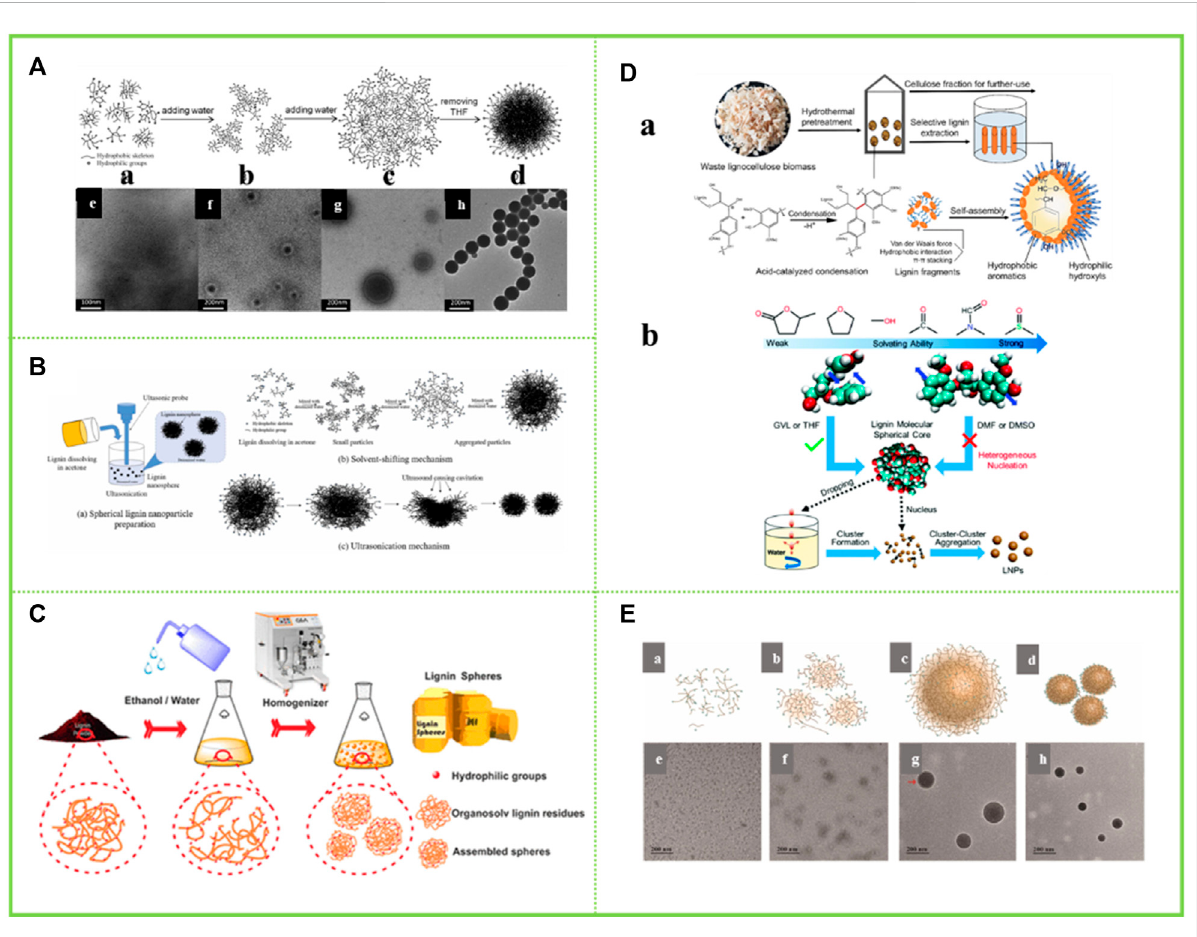
FIGURE 4 (A) Schematic representation of the colloid formation process of the acetylated lignin (ACL) in a THF – H 2 O medium and TEM images of the samplesobtainedfromthedispersionswithdifferentwatercontents(Qianetal.,2014b) (B) Schematicof(a)sphericalligninnanoparticlepreparation; (b) self-assembly mechanism and (c) ultrasonic mechanism (Rao et al., 2017) (C) Schematic diagram shows the aggregation and regeneration of the OLR-based submicron spheres (Rao et al., 2017) (D) Lignin condensation facilitates its solution based self-assembly for the production of LNCs with spherical structure (Chen et al., 2020), formation mechanism of LNCs from different solvents (Chen et al., 2022) (E) Proposed schematic illustration of colloid formation process of the lignin in DES (Zhang et al., 2022). (A) Copyright 2014 Royal Society of Chemistry (B,C)